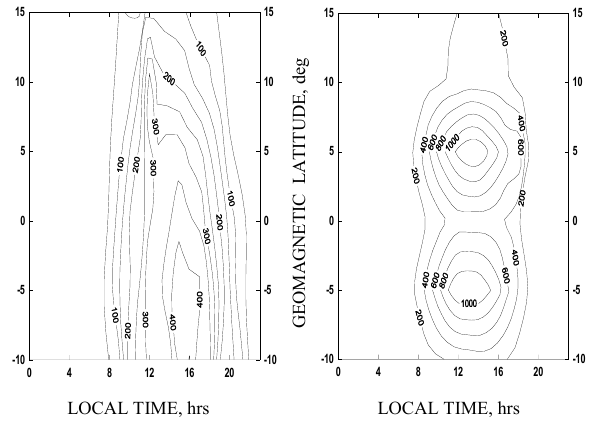
Fig. 8. Latitudinal and local time variation of observed (left panel) and simulated (right panel) O + density at an altitude of ∼ 500km within the geomagnetic latitude range from 10 ◦ S to 15 ◦ N during December solstice of low solar